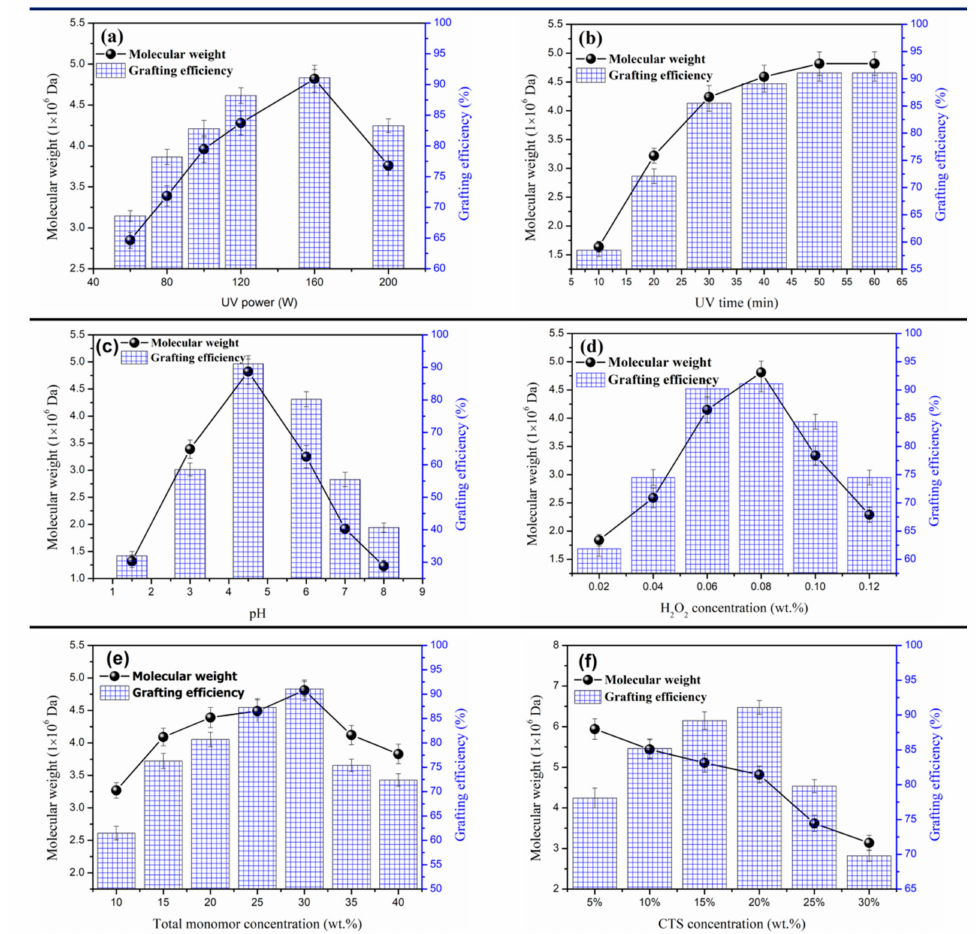
Figure 2. The e ff ect of di ff erent single factors on the MW and chitosan (CTS) grafting e ffi ciency of CTS-g-PAMD: ( a ) UV power, ( b ) UV time, ( c ) pH, ( d ) H 2 O 2 concentration, ( e ) total monomer concentration and ( f ) CTS